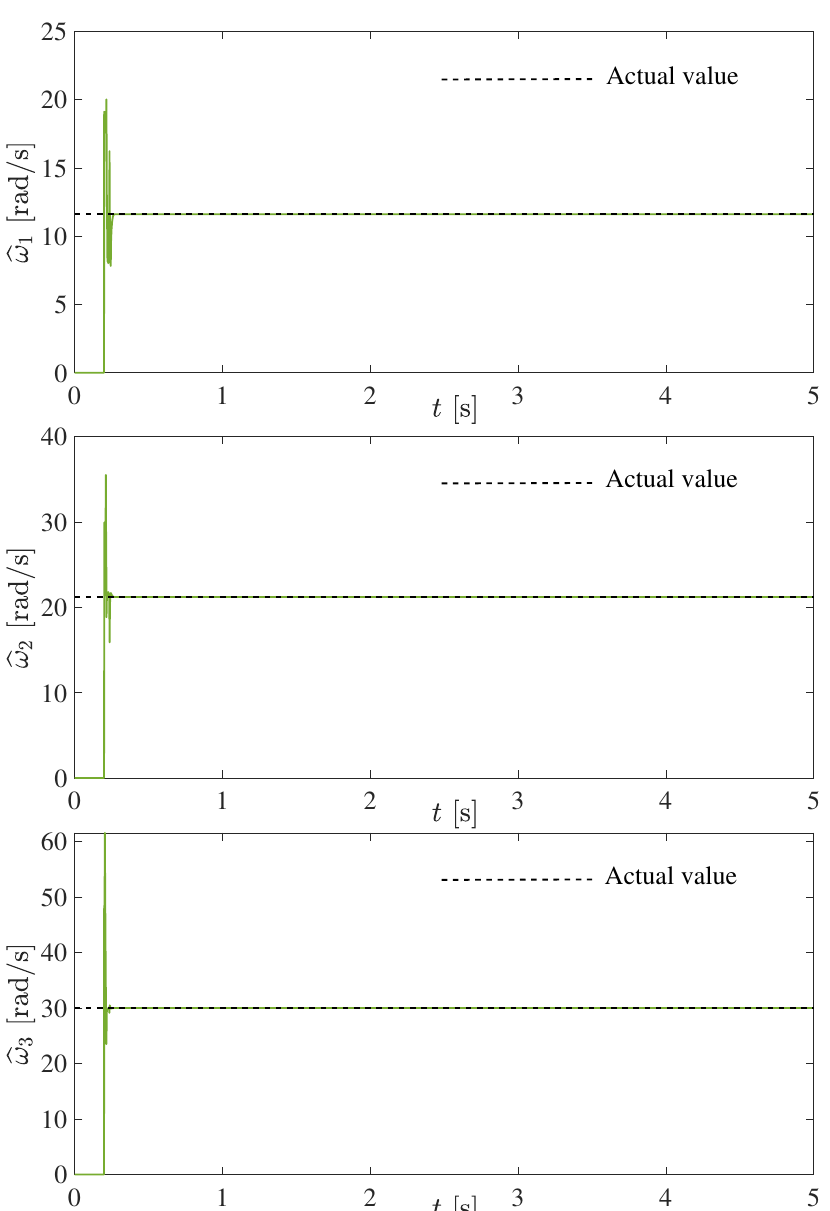
Figure 1. Online algebraic estimation of the three natural frequencies for the 3 DOF vibrating mechani- cal system